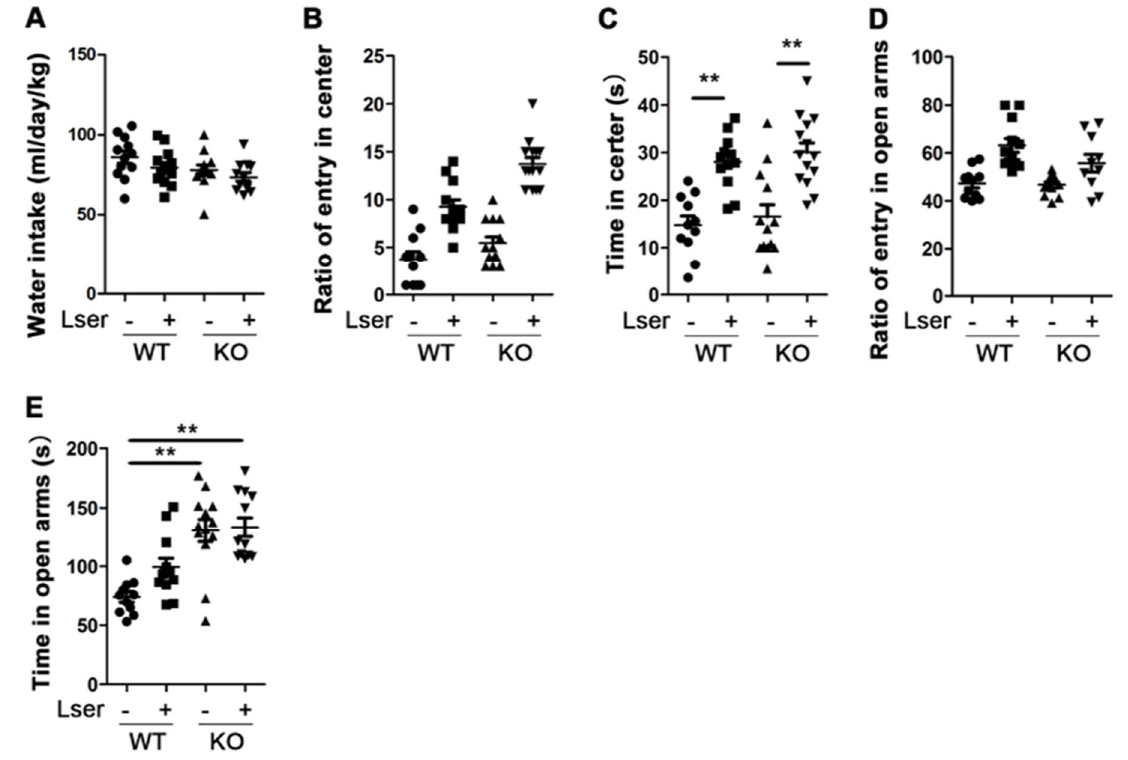
Figure 1. Oral administration of L-serine reduced anxiety-related behavior in mice. GHRH-KO mice and age-matched wild type controls were subject to oral administration of L-serine for 12 weeks before EZM and OFT. ( A ) Water intake. ( B ) Ratio of entry in the center during the entire OFT time. ( C ) Time spent in the center during the entire OFT time. ( D ) Ratio of entry in open arms during the entire EZM trial. ( E ) Time spent in open arms during the entire EZM trial. n = 11–14 mice per group. Data are means ± SEM. ** p < 0.01.